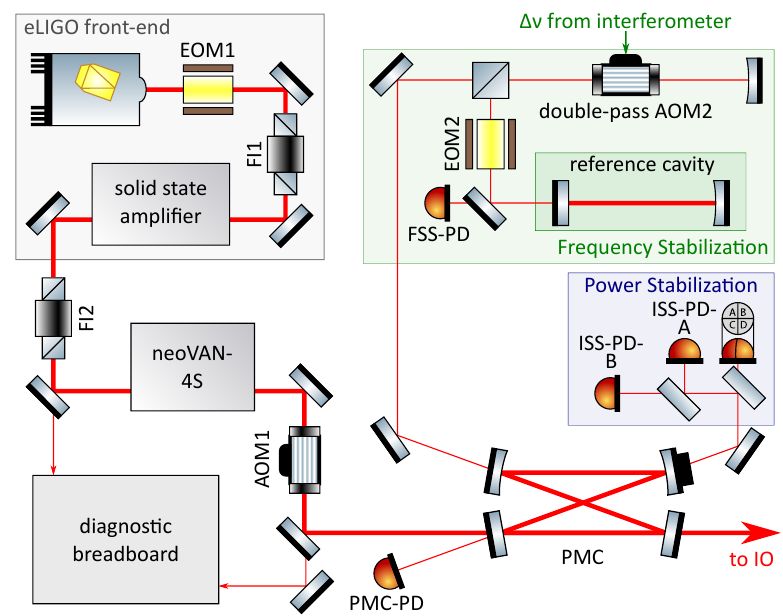
Figure 1. Schematic diagram of the aLIGO O3 pre-stabilized laser system. An eLIGO front-end seeded the neoVAN-4S amplifier delivered an output power of 70W. The main beam was sent through the PMC and then to the interferometer’s input optics. The two low power output beams from the PMC were used for the frequency and power pre-stabilization